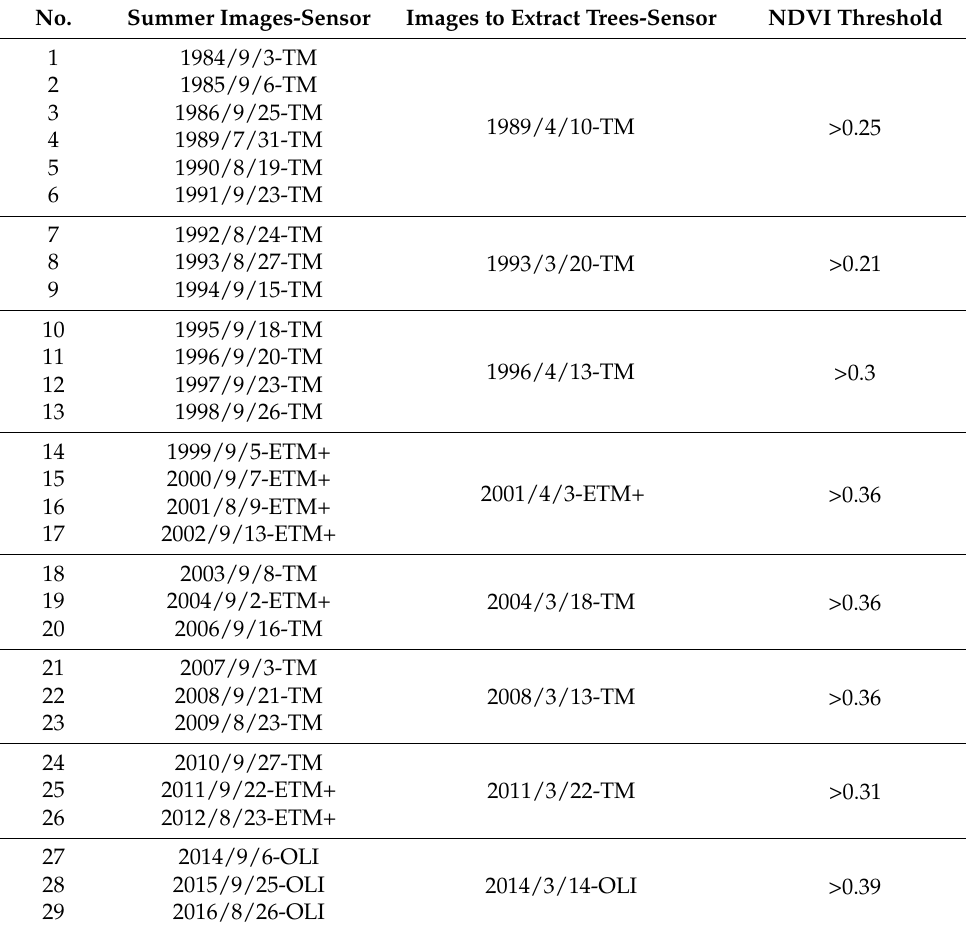
Table 1. List of Landsat images